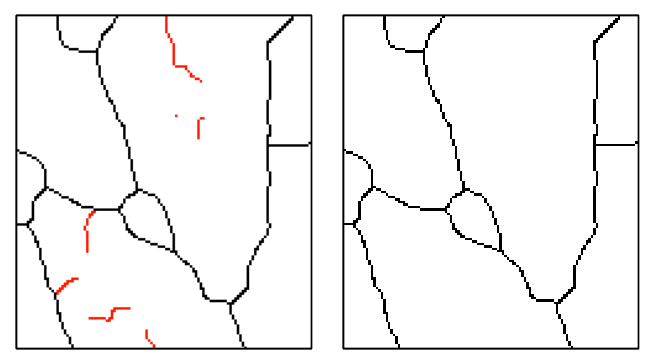
Figure 8. Skeleton before and after filtration.